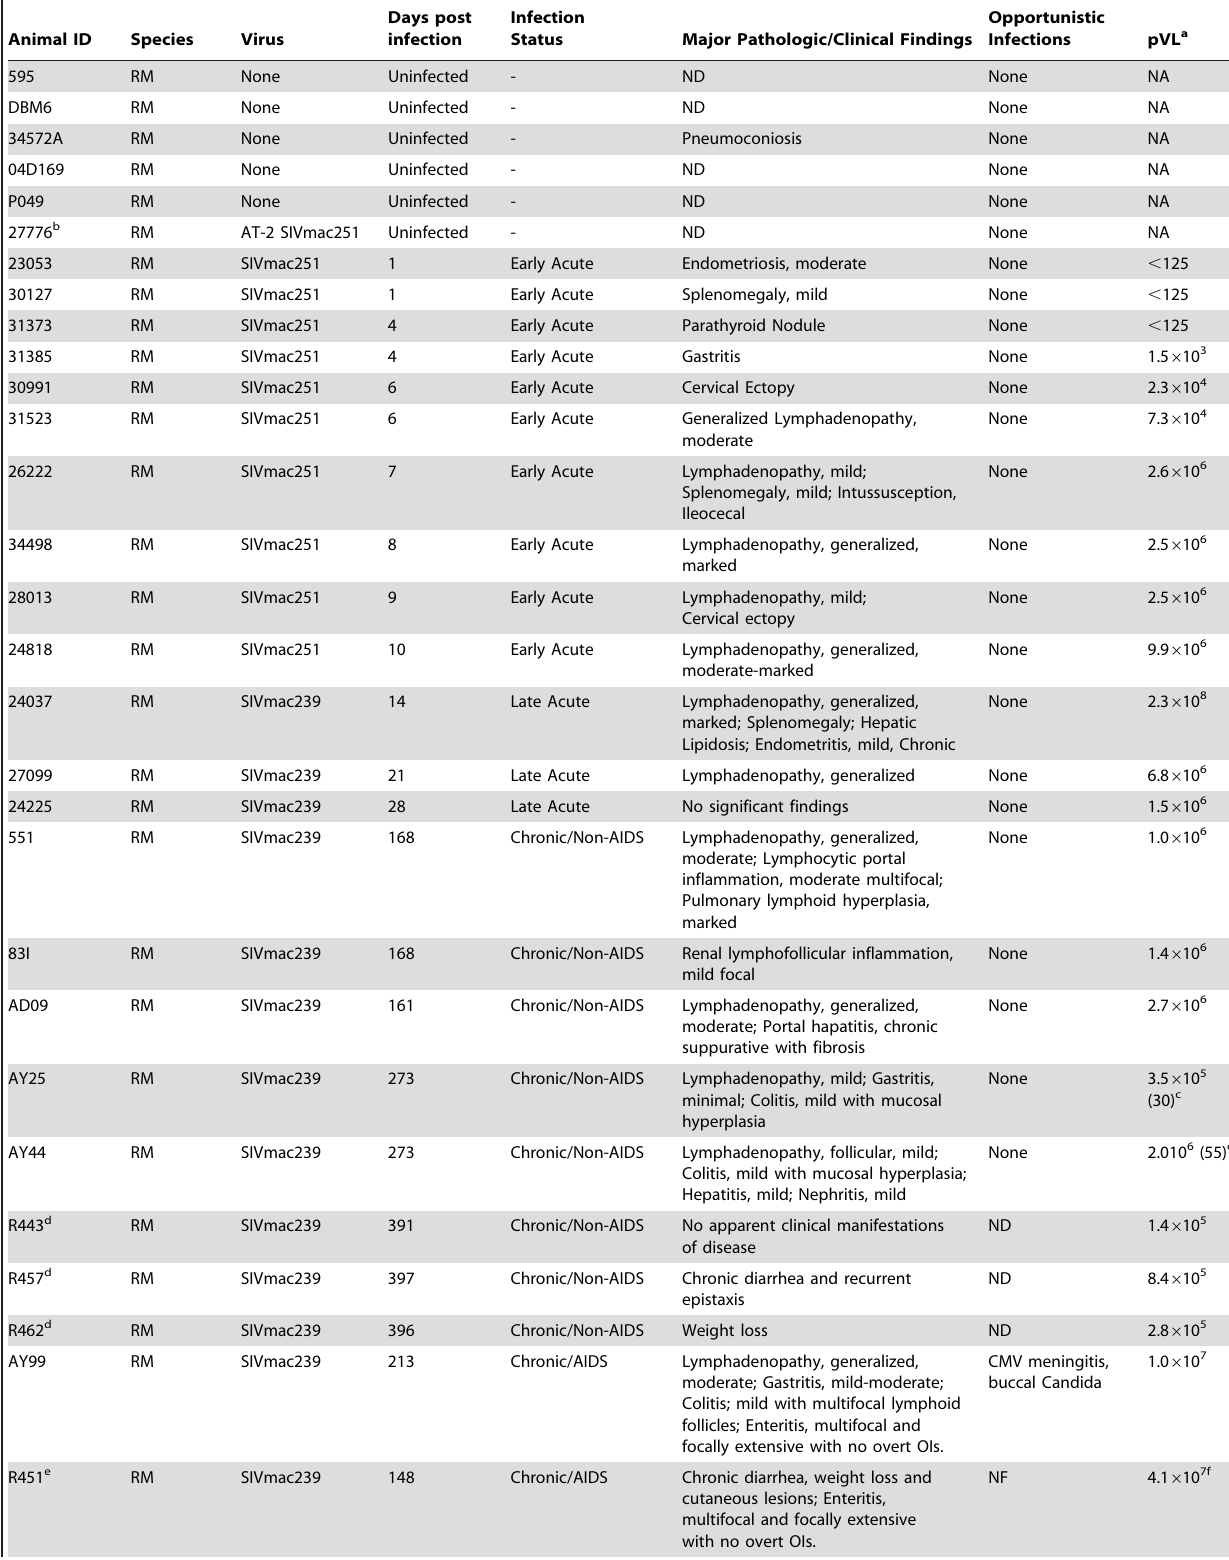
Table 1. Animals used for study.